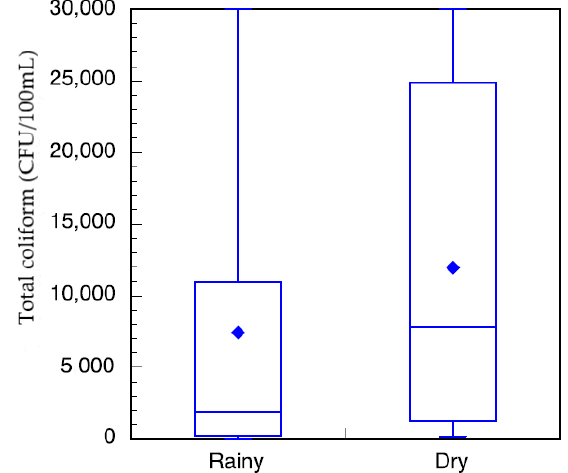
6 Figure 6. Box-and-whisker plot of total coliform measurements of stored, untreated water in study households in the wet (n = 95) and dry (n = 103) seasons. The box-and-whisker plot indicates the mean (diamond), first, second, and third quartiles (box), and minimum and maximum